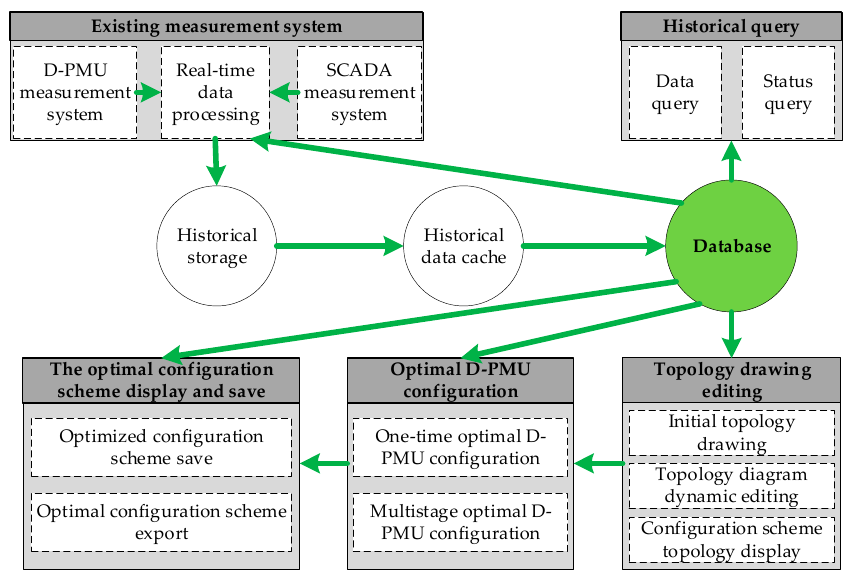
Figure 7. Data flow diagram of the software system.